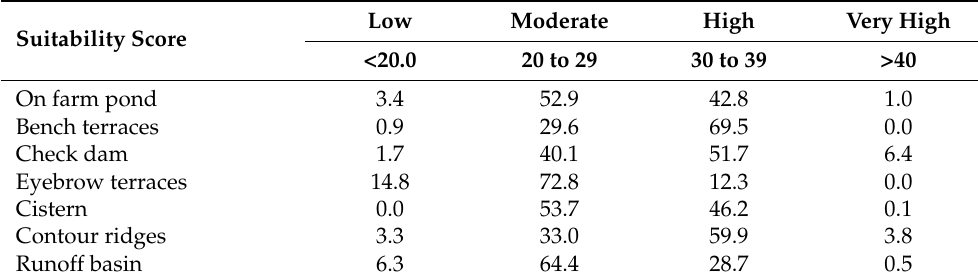
Table 2. Percentage of the WB suitable for different RWH